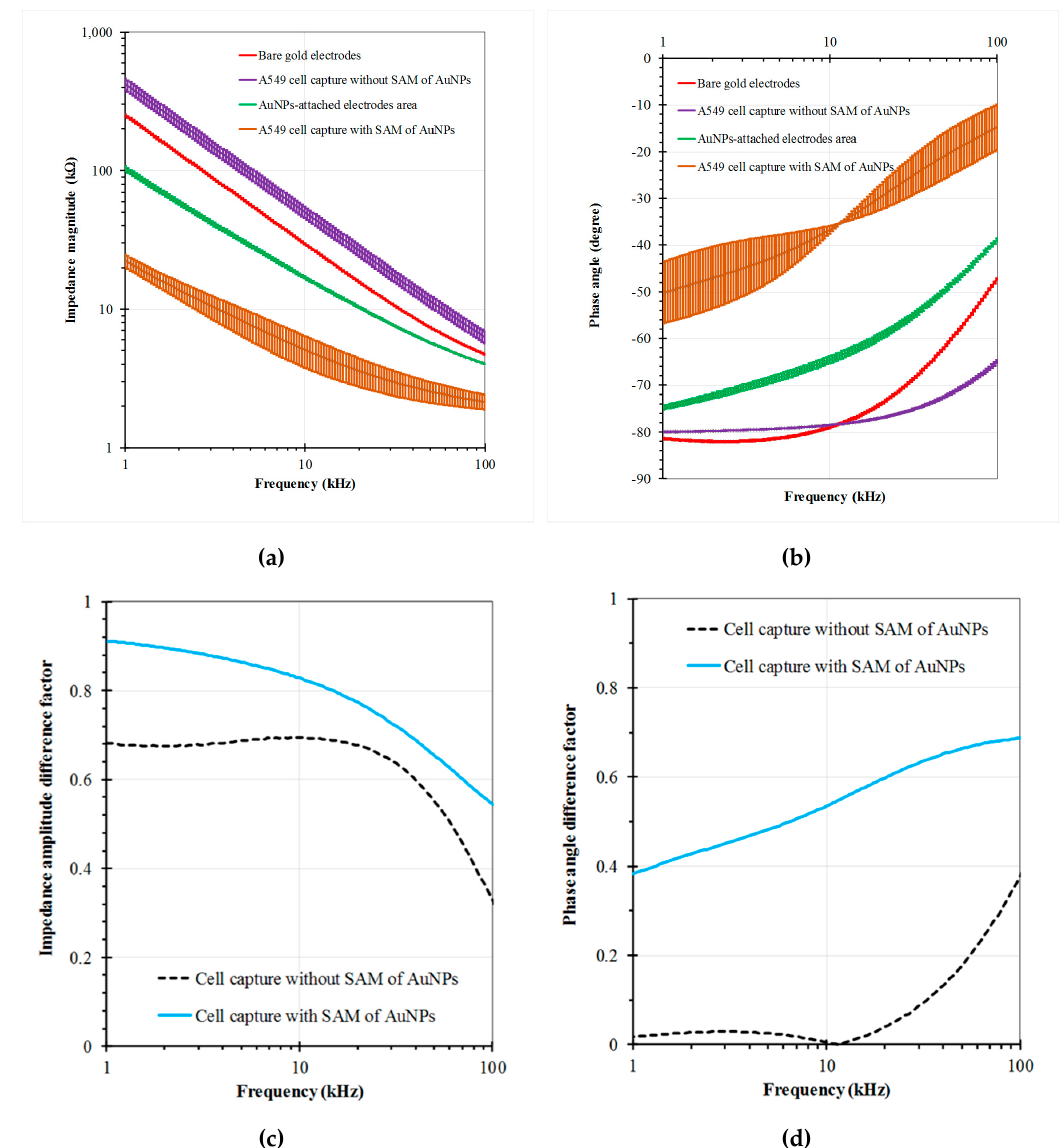
Figure 4. Impedance responses of the electrodes in the buffer microfluidic channel as a function of frequency in 4 measurements, respectively: the initial gold microelectrodes, the aptamer-modified gold electrodes without SAM of AuNPs after cell capture, the gold electrodes with SAM of AuNPs, and the modified electrodes with SAM of AuNPs after cell capture, with a voltage amplitude of 50 mV, and a frequency range from 1 to 100 kHz: ( a ) Impedance magnitude; ( b ) Phase angle; ( c , d ) Impedance and phase angle difference ratios of the cell-captured electrodes with respect to the initial electrodes in two cases, without and with SAM of AuNPs, respectively. The A549 cell samples at the same concentrations of 5 × 10 2 cells/µL were used herein.